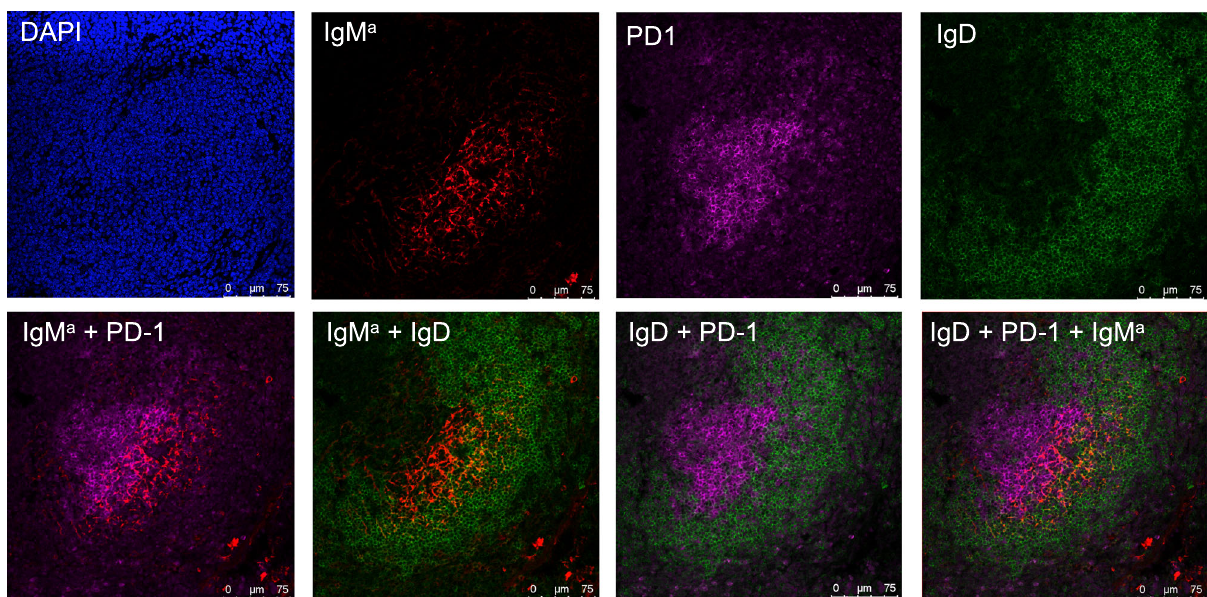
Fig. 8 CTLA-4-de fi cient B-1a cells are localized in close association with FDCs in transfer recipient spleen. Spleen sections of recipients that have been received peritoneal B-1a cells from CTLA-4 B-cell CKO mice were analyzed by immuno fl uorescence confocal microscopy. Representative immuno fl uorescence images of the section stained with indicated individual reagent are shown in the upper and images of two or three-color composites are shown in the